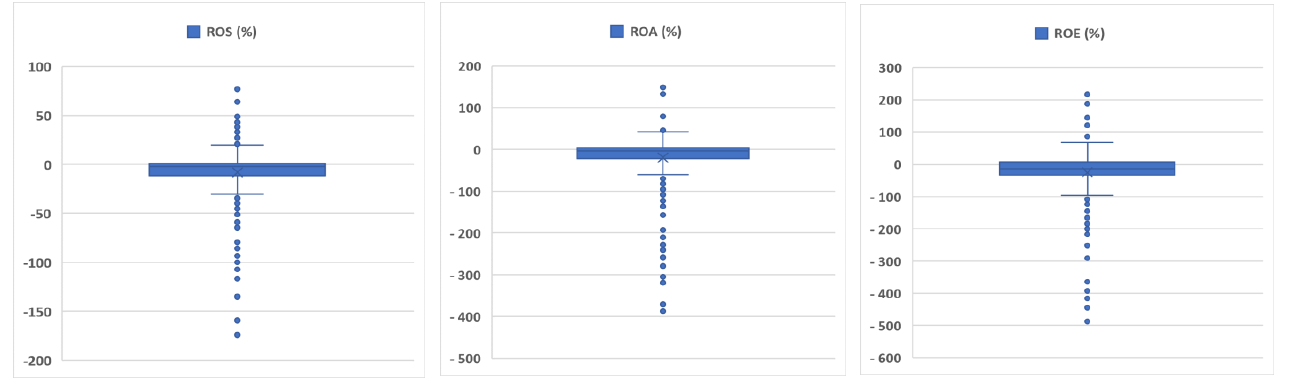
Figure 2. Distribution of the ROS, ROA and ROE averages (%) for Romanian companies without outliers. Source: Authors ’ own editing, based on own calculations. The distribution of the mean values for ROS (Return on Sales), ROA (Return on Assets) and ROE (Return on Equity) without outliers is shown in Figures 1 and 2. In the end, the numbers of the remaining companies in the two databases were as follows: the Romanian database contained 640, while the Hungarian database contained 190 companies.